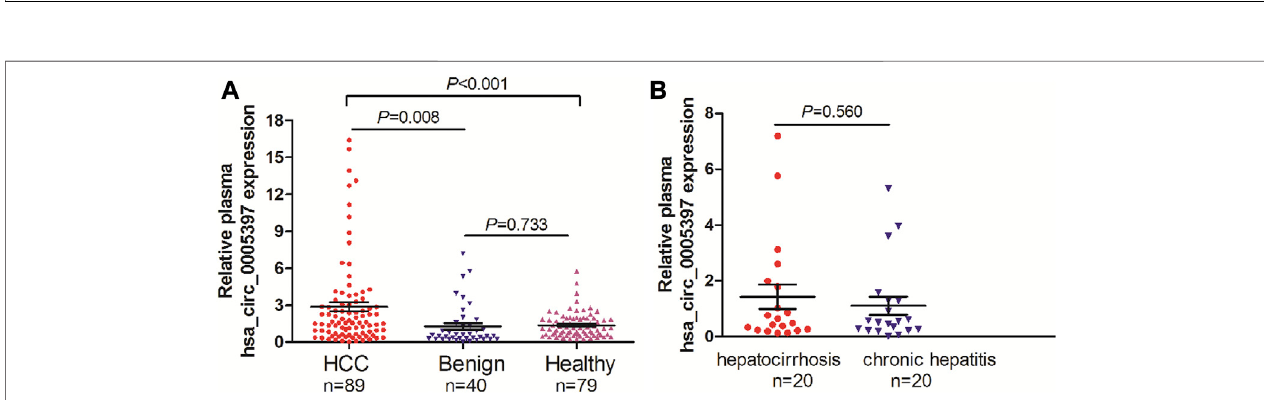
FIGURE 1 | Screening of candidate plasma circRNA in patients with HCC. Detection of plasma expression levels of 4 candidate circRNAs, hsa_circ_0005397 (A) , hsa_circ_0006302 (B) , hsa_circ_0088494 (C) and hsa_circ_0083766 (D) , by qRT-PCR analyses in 15 HCC vs. 15 healthy controls.